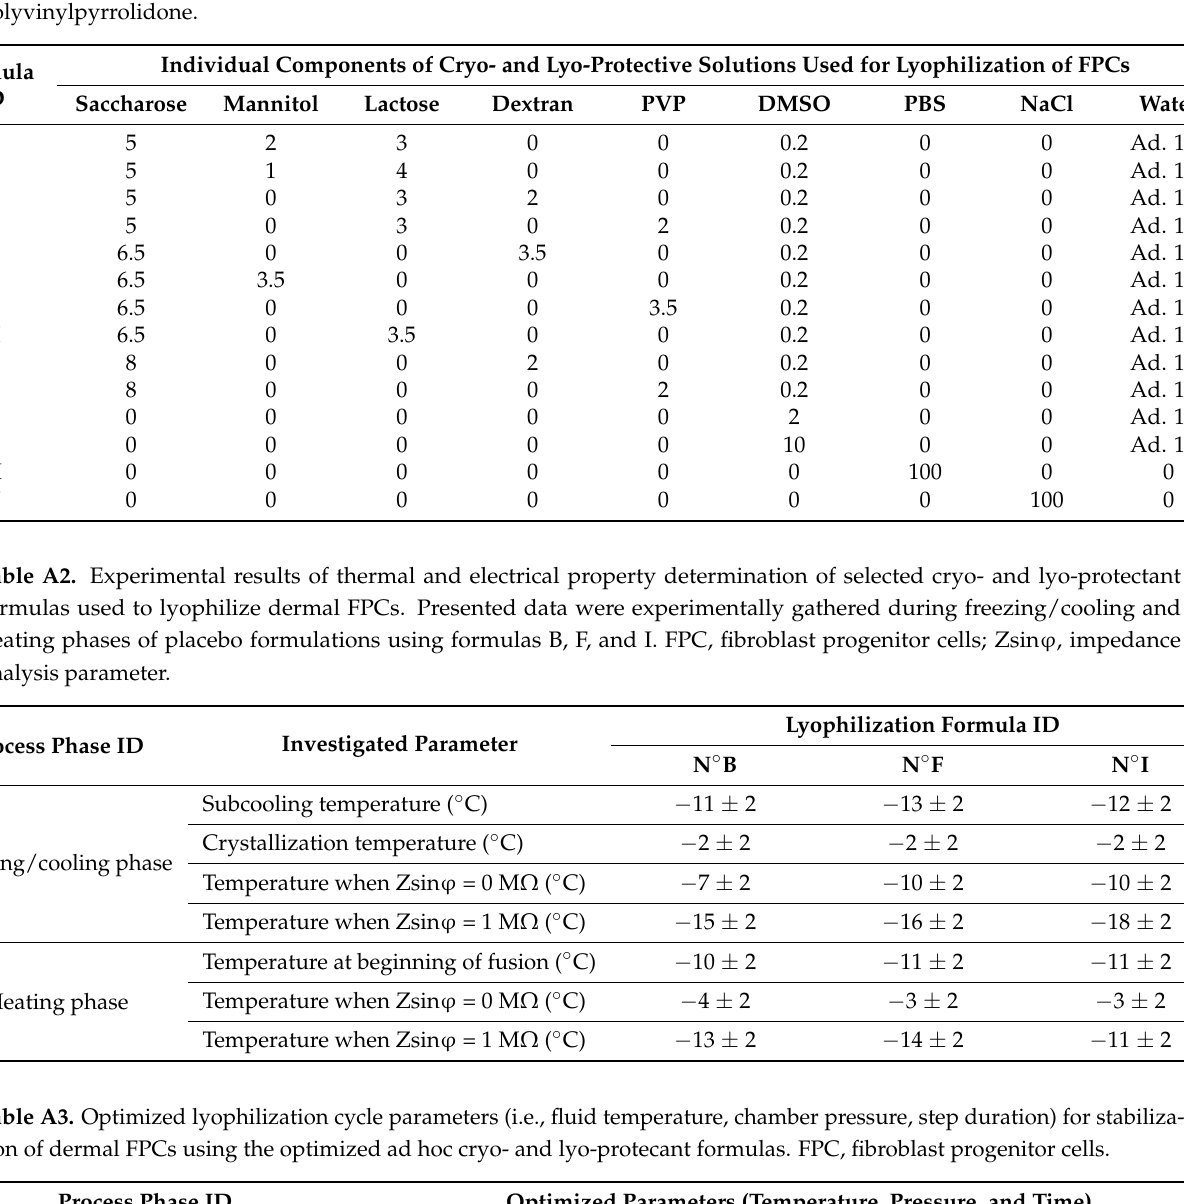
Table A1. Qualitative and quantitative compositions of the cryo- and lyo-protective solutions used for lyophilization of dermal FPCs. Formulation tonicity was corrected upon lyophilizate reconstitution, by addition of water and PBS in appropriate proportions. Quantities are presented in m/v percentages for sugars, salts, and polymers, and in v / v percentages for buffers and solvents. DMSO, dimethyl sulfoxide; FPC, fibroblast progenitor cells; PBS, phosphate-buffered saline; PVP, polyvinylpyrrolidone.